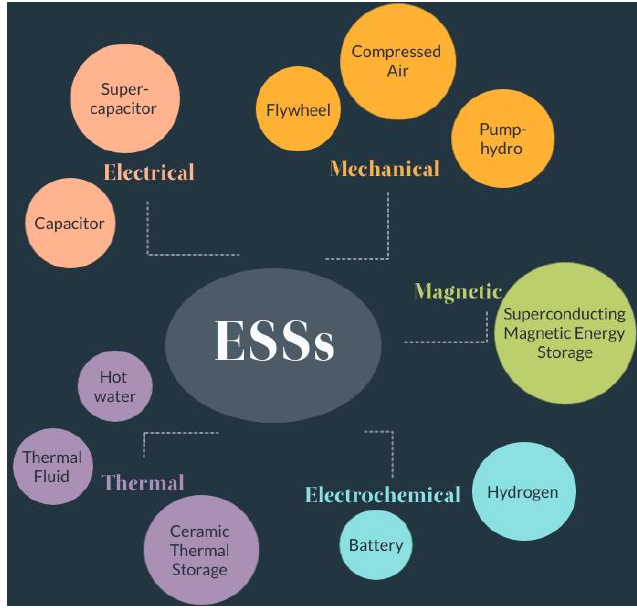
Figure 10. Different types of energy storage systems (Note: ESSs—energy storage systems). Figure 10. Di ff erent types of energy storage systems (Note: ESSs—energy storage